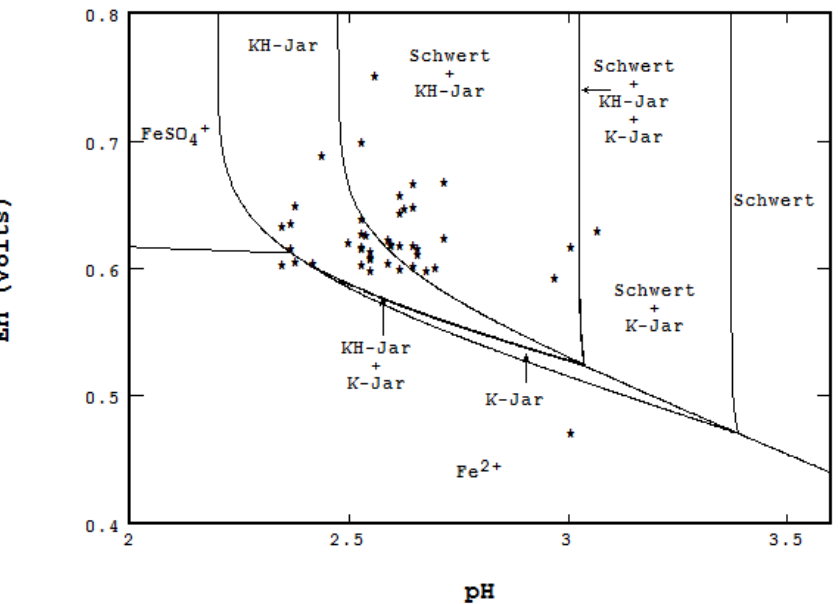
Figure 16. Mass balanced Eh-pH diagram for the Fe–K–S system at 7 °C. This diagram shows the coexistence among schwertmannite, K-jarosite and KH-jarosite. * represents the data analyzed from the sampled water.